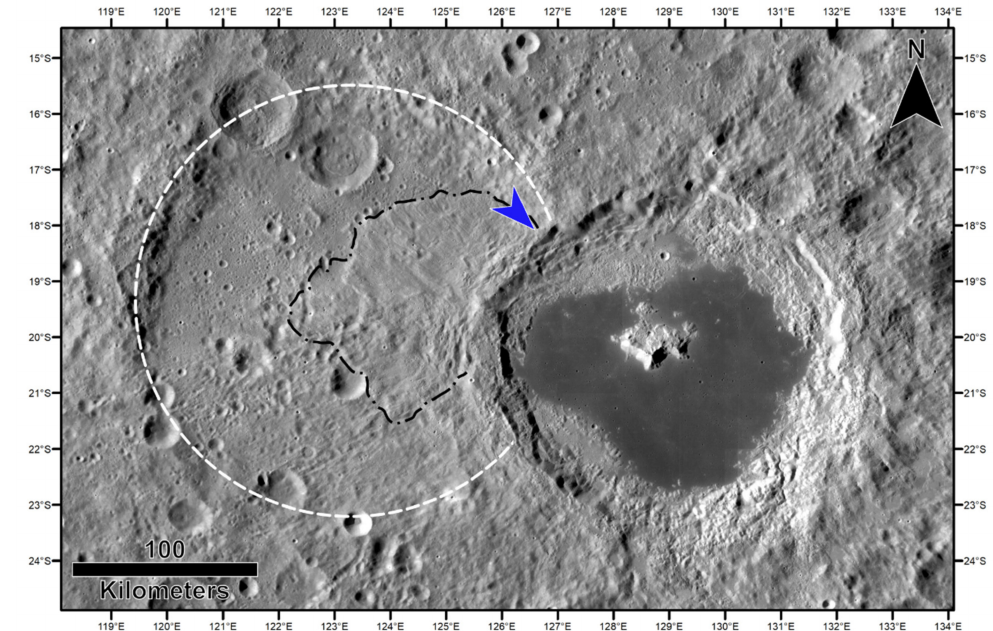
Figure 1. Structure of Tsiolkovskiy (on the right) superposing on the ~230 km diameter Fermi crater (on the left). The white dashed circle identifies the approximate rim of Fermi; the black dashed and dotted line delimits Tsiolkovskiy’s landslide, modified from [14]; the blue arrow indicates the impact direction for